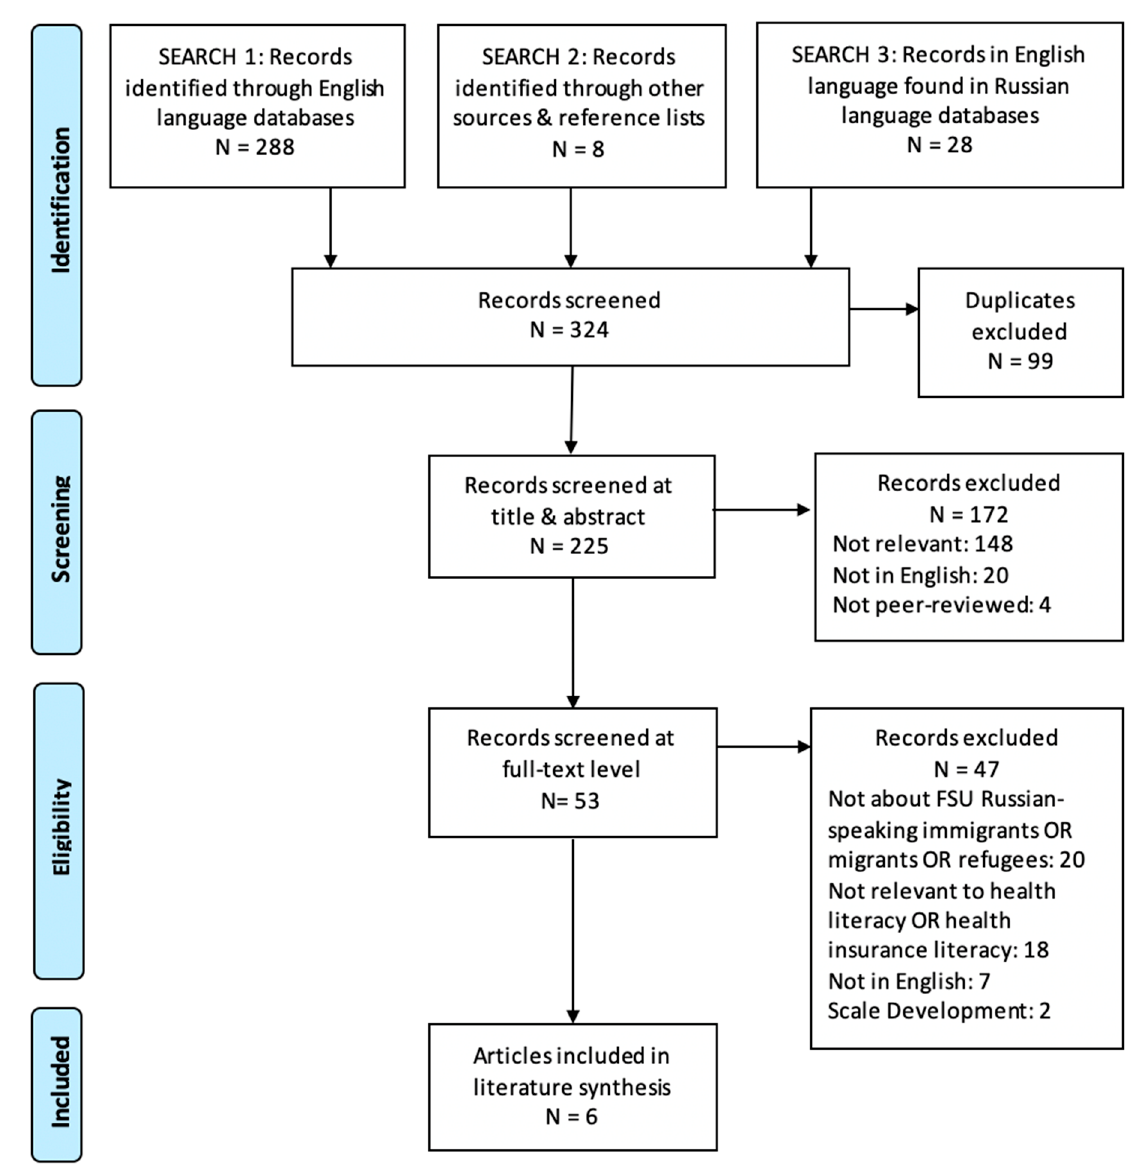
Figure 1. PRISMA flow diagram for English language articles [50].